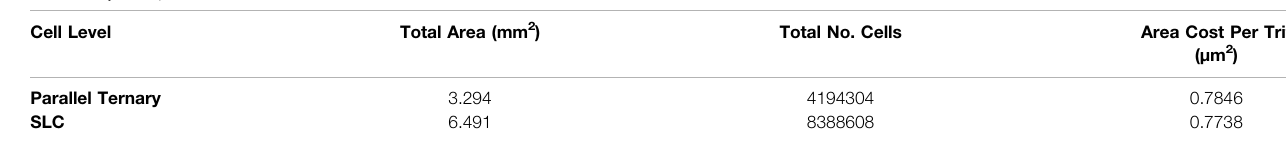
TABLE 4 | Cost per